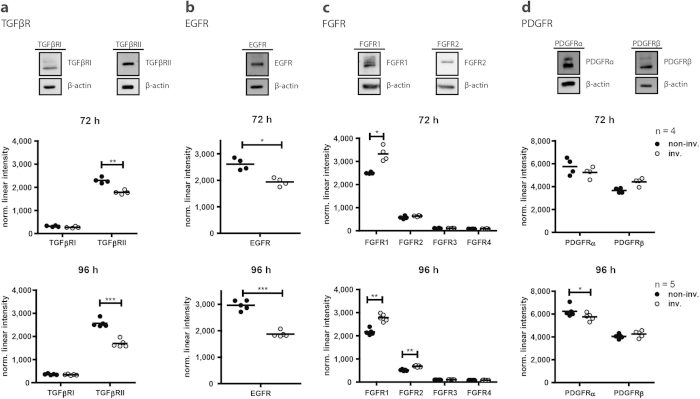
Expression levels of growth factor receptors.The baseline expression levels of transforming growth factor (TGF)β receptors I (TGFβRI) and II (TGFβRII), epidermal growth factor (EGF) receptor (EGFR), fibroblast growth factor (FGF) receptor 1 (FGFRI) and 2 (FGFR2), and platelet derived growth factor (PDGF) receptor alpha (PDGFRα) and beta (PDGFRβ) were determined by immunoblot analysis (a–d upper panel). Expression levels upon invasion at 72 hours (72 h) (a–d middle panel) and 96 hours (96 h) (a–d lower panel) were extracted from the microarray data. Statistical analysis: paired t-test. *p < 0.05, **p < 0.01, and ***p < 0.001.